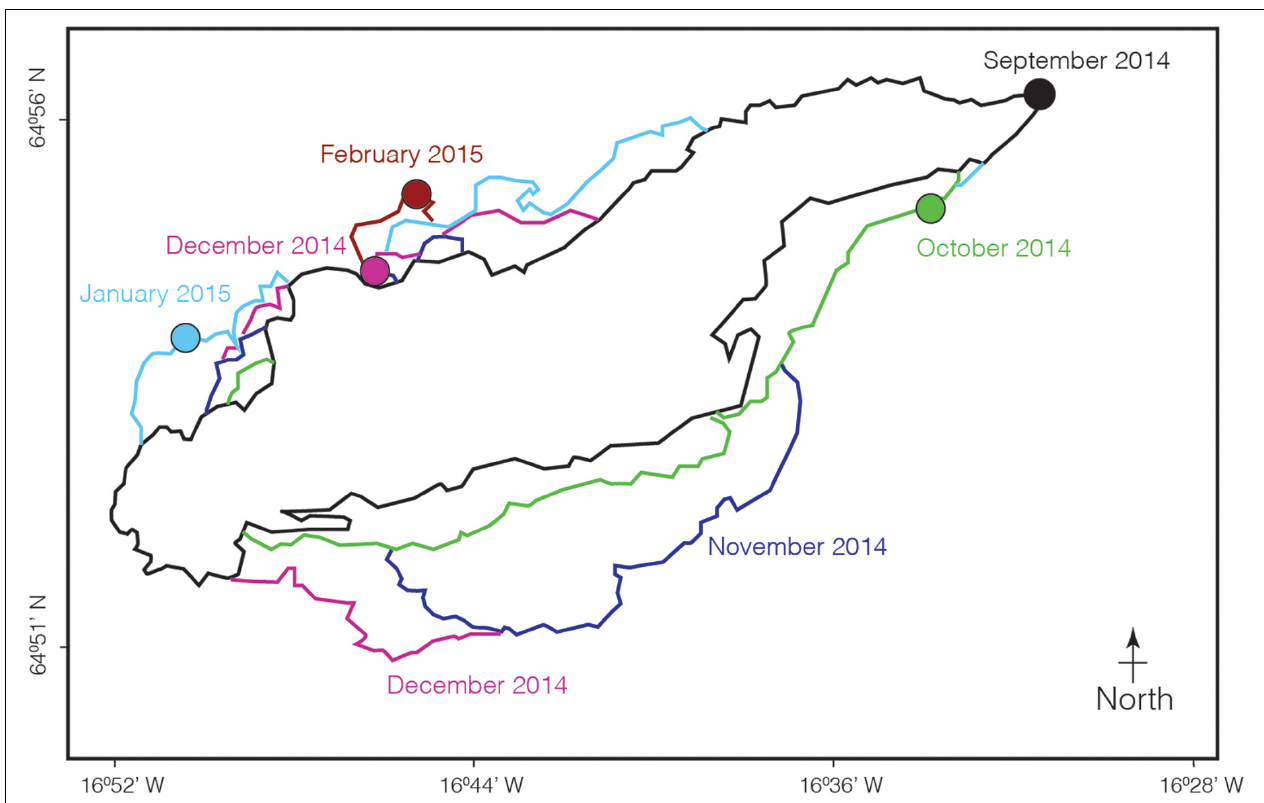
FIGURE 1 | Outlines of the Holuhraun–Bárdarbunga lava flow were drawn on the base of satellite images collected at different times. These images are available on the web-page of the Icelandic Meteorological Office. The circles indicate the sampling locations.